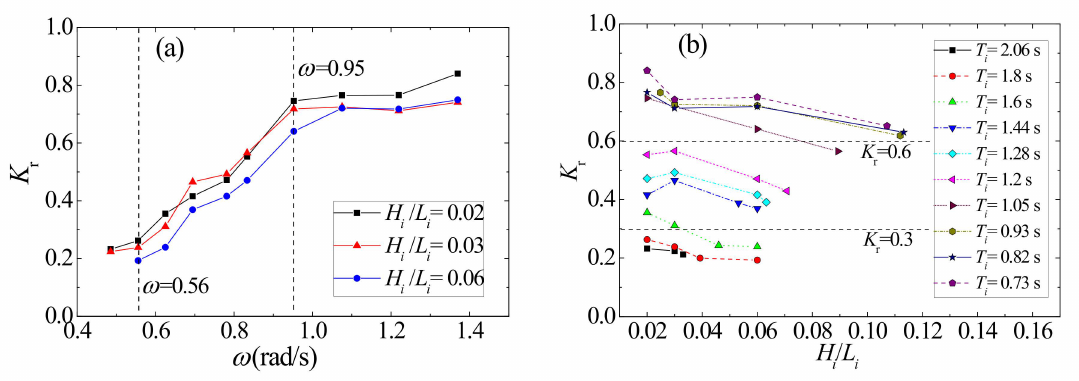
Figure 9. Wave reflection coe ffi cients with various wave frequencies and wave steepness values: ( a ) e ff ect of wave frequency; ( b ) e ff ect of wave